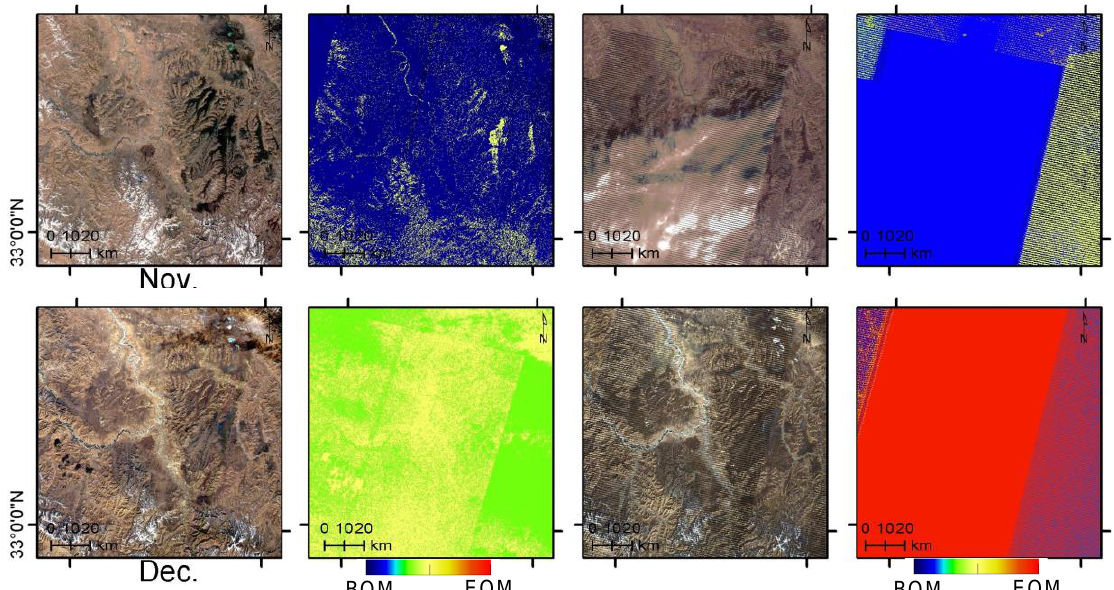
Figure 6. The visual consistency evaluation (from left to right): ( column 1 ) browse images of HJ-1A/B composites (true color); ( column 2 ) HJ corresponding DOY flag images; ( column 3 ) browse images of Landsat Web-Enabled Landsat Data (WELD) composites (true color); ( column 4 ) WELD corresponding DOY flag images. The black color in February and October in WELD represents no data pixels. “BOM” means beginning of month, and EOM means end of month.